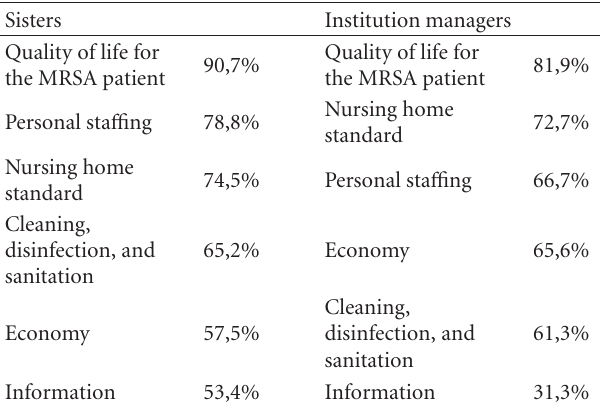
Table 2: Ranging the challenges associated with MRSA in nursing